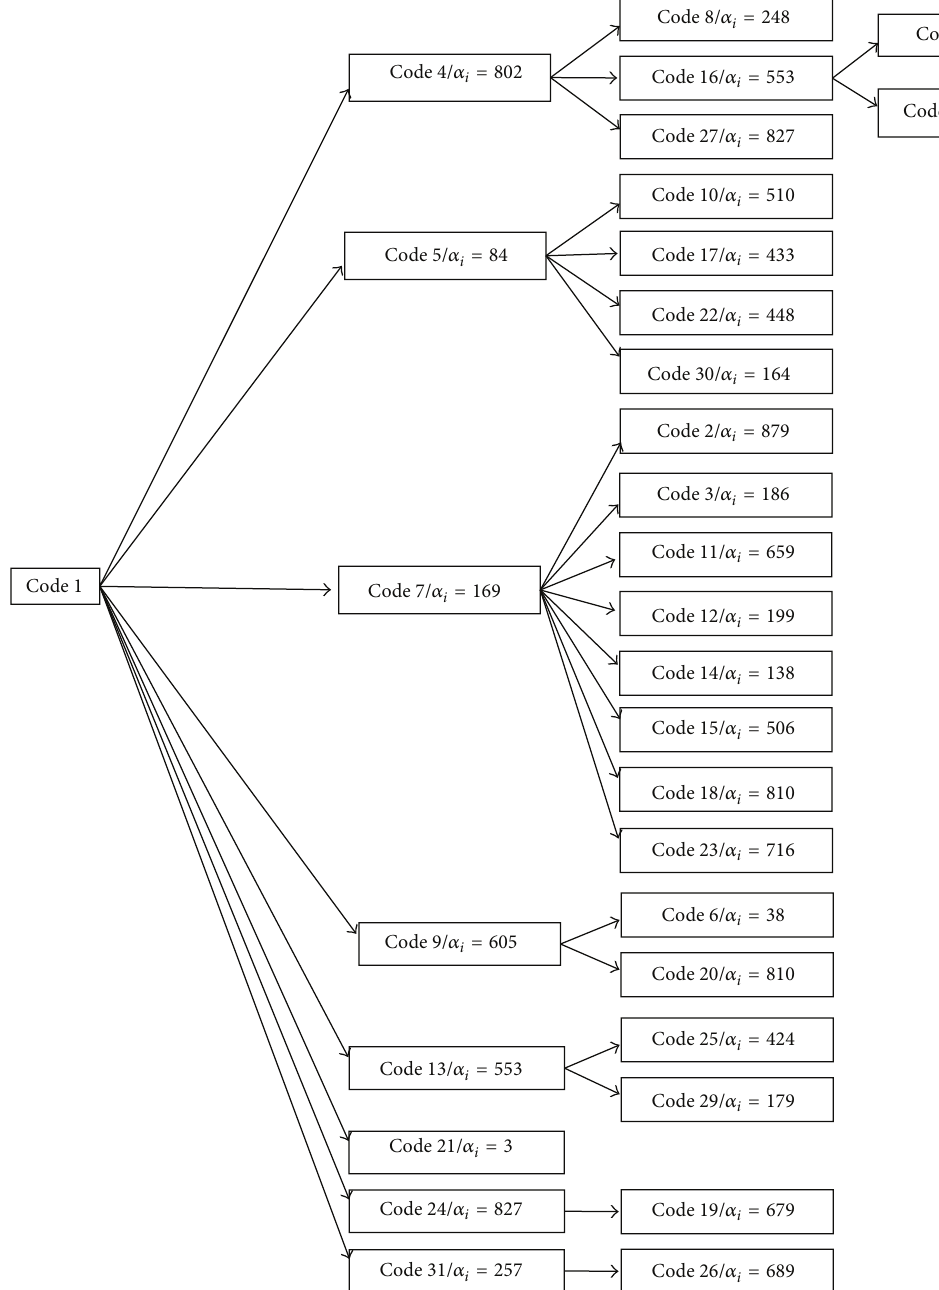
Figure 6: Flow chart showing the relation between all C/A-GPS